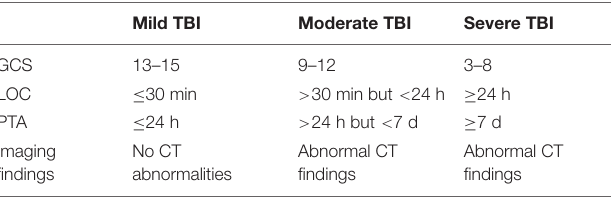
TABLE 1 | Guidelines for the diagnosis of TBI